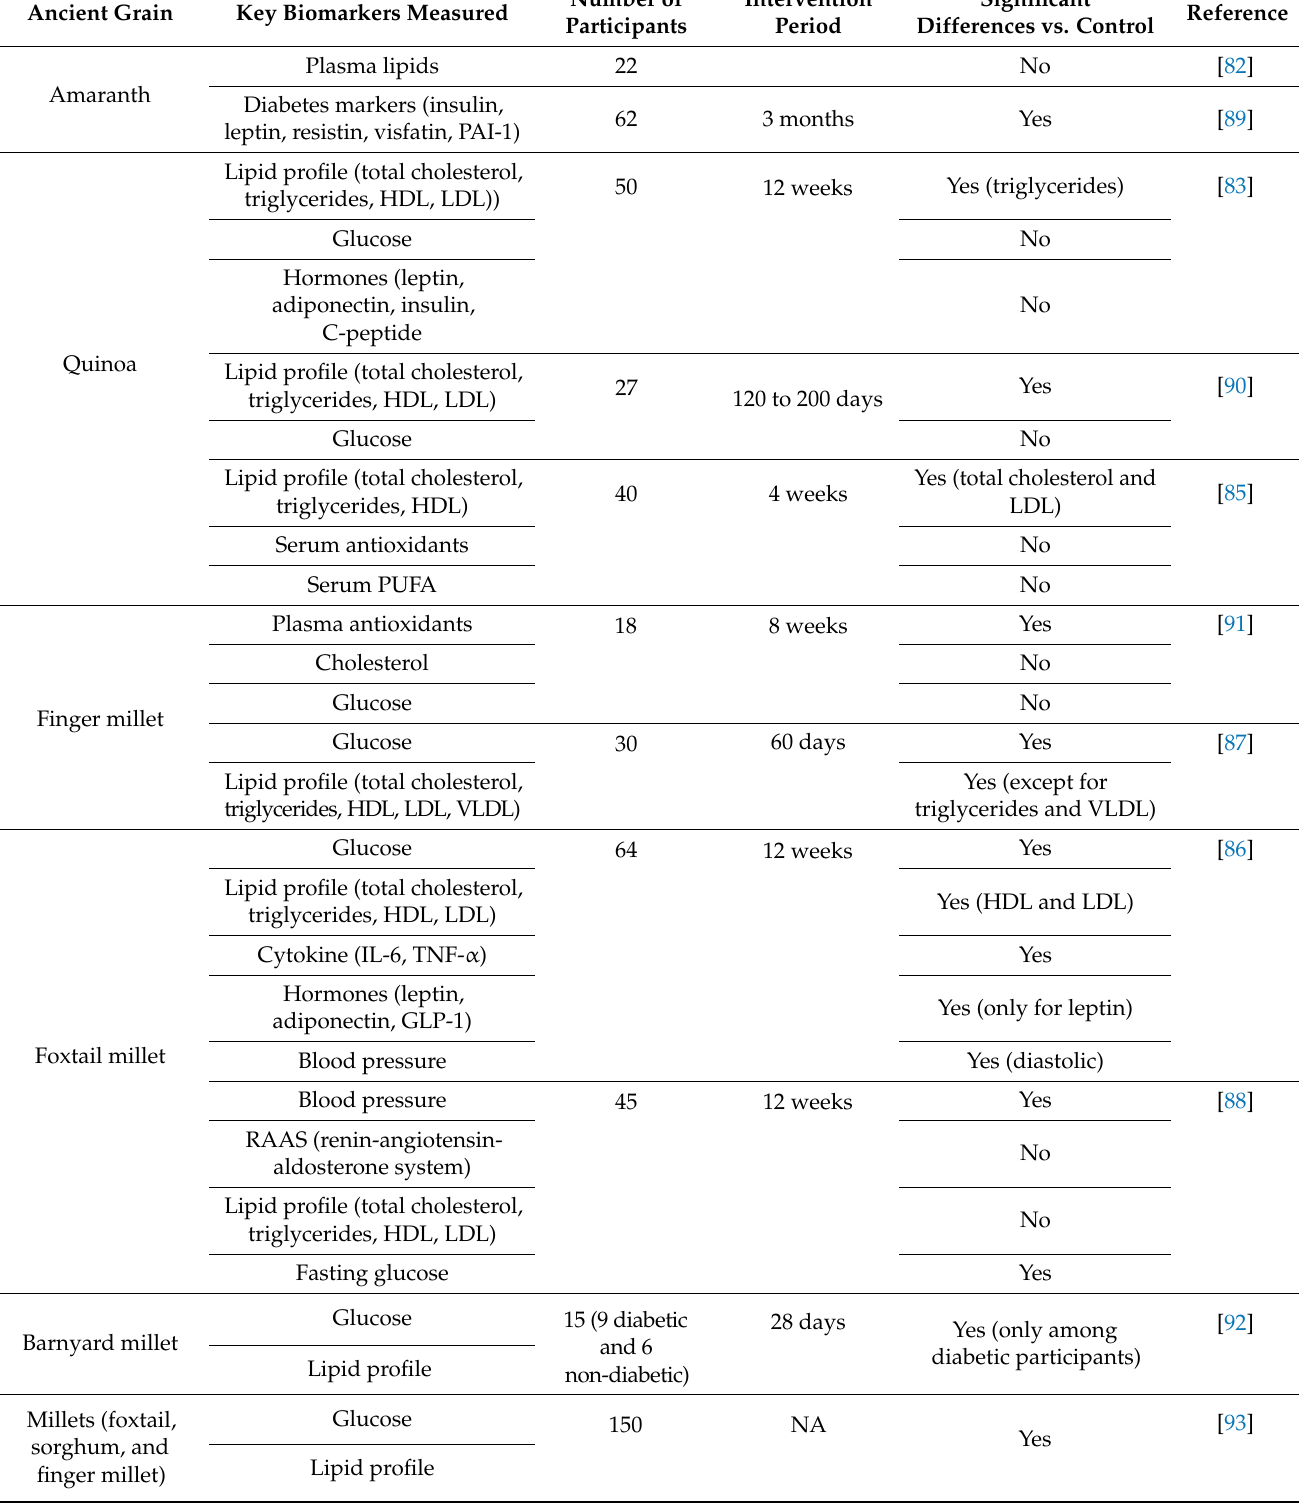
Table 4. Clinical trials on amaranth, quinoa, and millet products to understand their antidiabetic, anti-obesity, anticholesterolemic, and anti-inflammatory